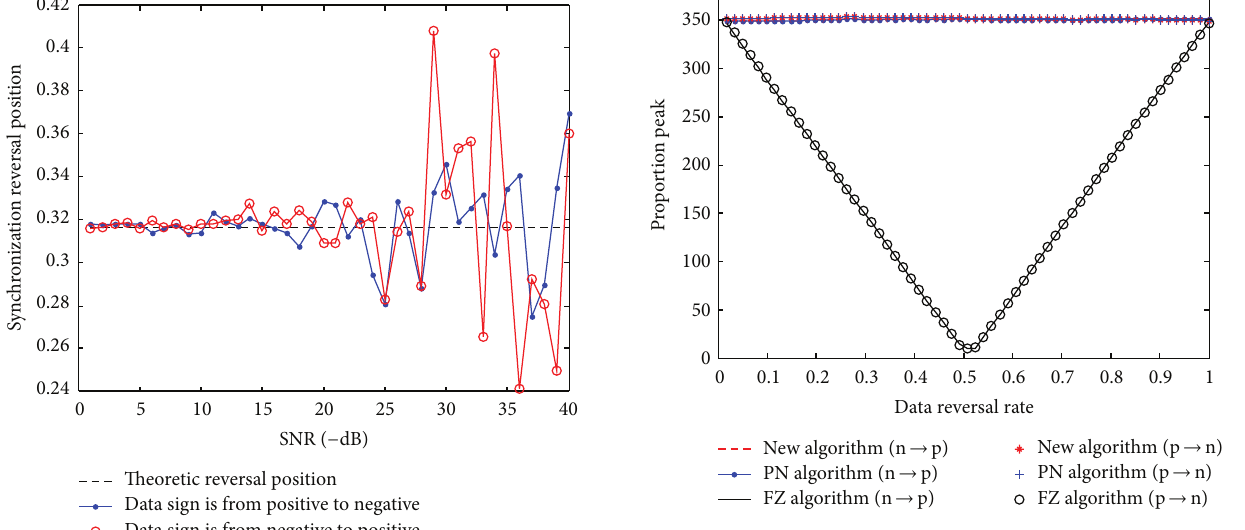
Figure 7: The proportion peak comparison with changing data reversal